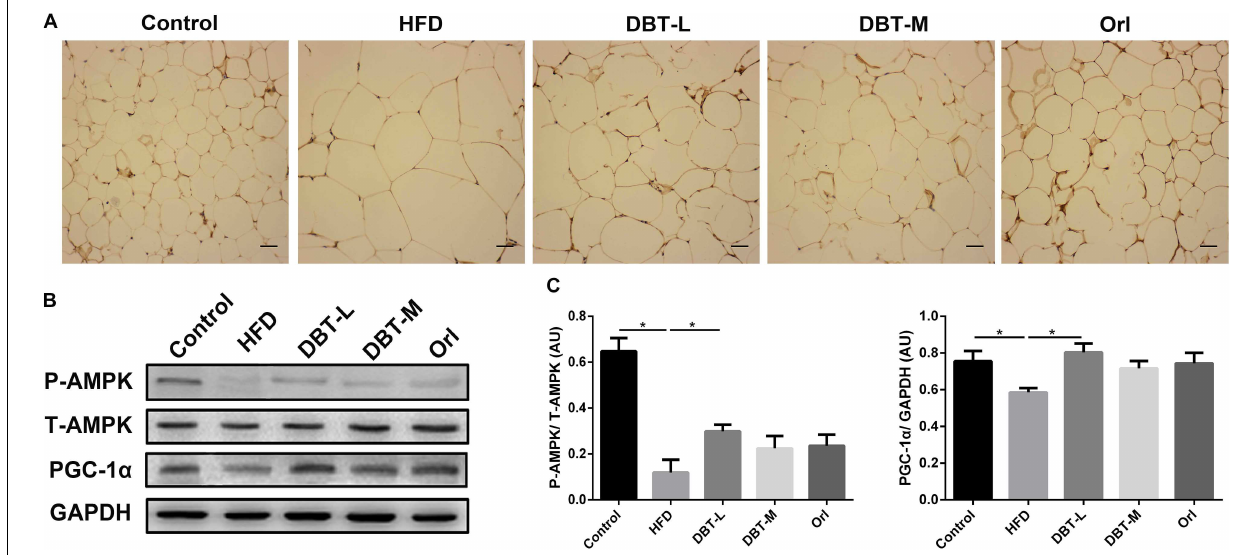
FIGURE 5 | DBT improves phosphorylation of AMPK in WAT. (A) Immunohistochemical of pAMPK in epididymal WAT; (B) The protein expression of phosphorylation or total AMPK and PGC-1 α with GAPDH as control; (C) Quantification of P-AMPK and PGC-1 α protein expression. Results are presented as mean ± SEM ( n = 7). ∗ p < 0.05 compare with HFD group.